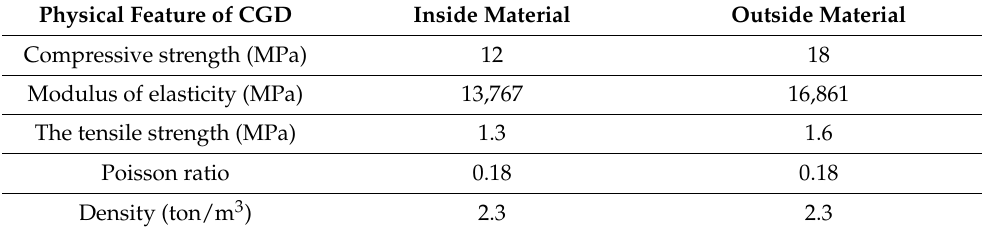
Figure 4. Bohyeonsan CGD; ( a ) real view; ( b ) data collection point in Bohyeonsan CGD. Table 1. Materials properties (designed) of Bohyeonsan concrete gravity dam (CGD). Physical Feature of CGD Inside